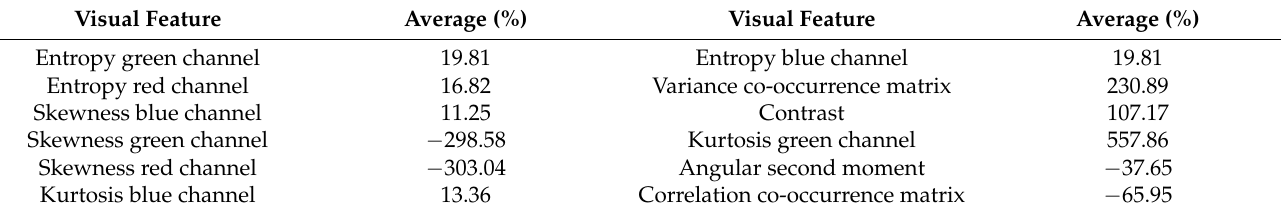
Figure 8. Entropy curves for the green channel of eight apple slices at nine instances of time. Table 3. Average percentage of variation for visual features.